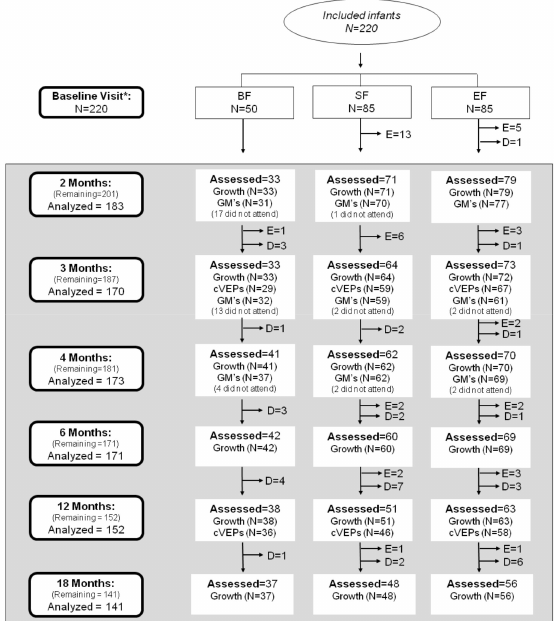
Figure 1. Study profile from baseline visit to 18 months old. Eighteen infants at 2 months, seventeen at 3 months, and eight at 4 months did not show up at the evaluations but remained in COGNIS study for later visits (described as “did not attend”). BF: breastfed infants; SF: standard infant formula; EF: experimental infant formula; D: dropouts; E: exclusions; GM’s: general movements; cVEPs: cortical visual evoked potentials. *BF infants were randomized between 0–6 months of